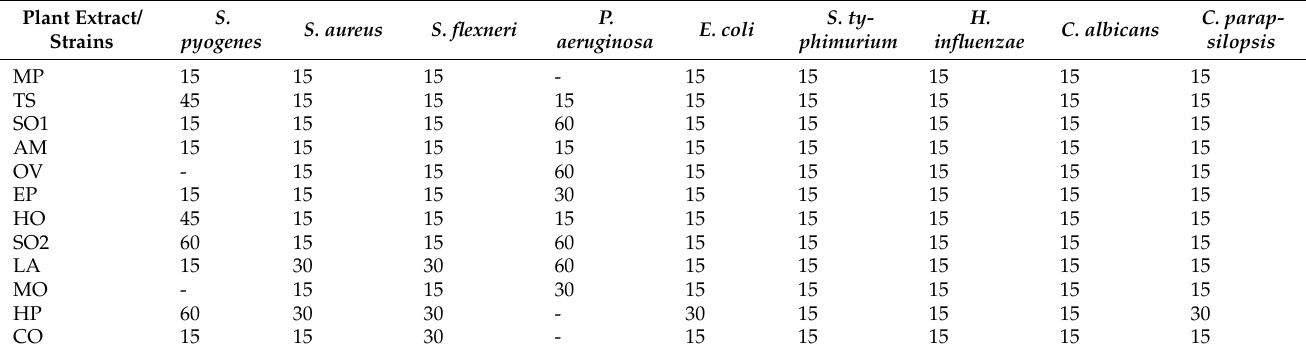
Table 5. The MIC values (mg/mL) for plant extracts against tested